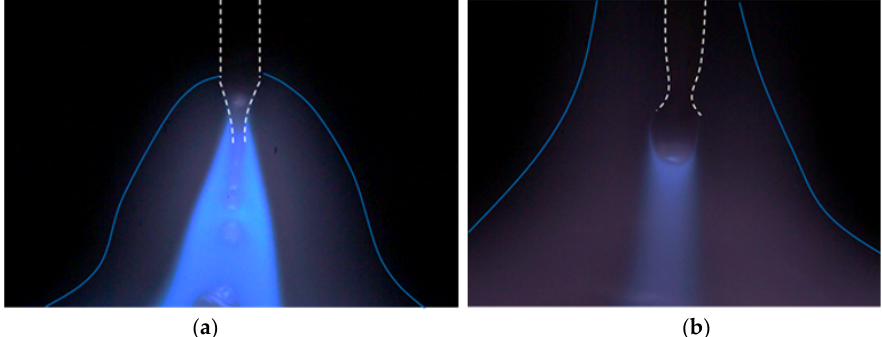
Figure 1. Arc and plasma appearance in ( a ) conventional MIG welding and ( b ) plasma–MIG welding.